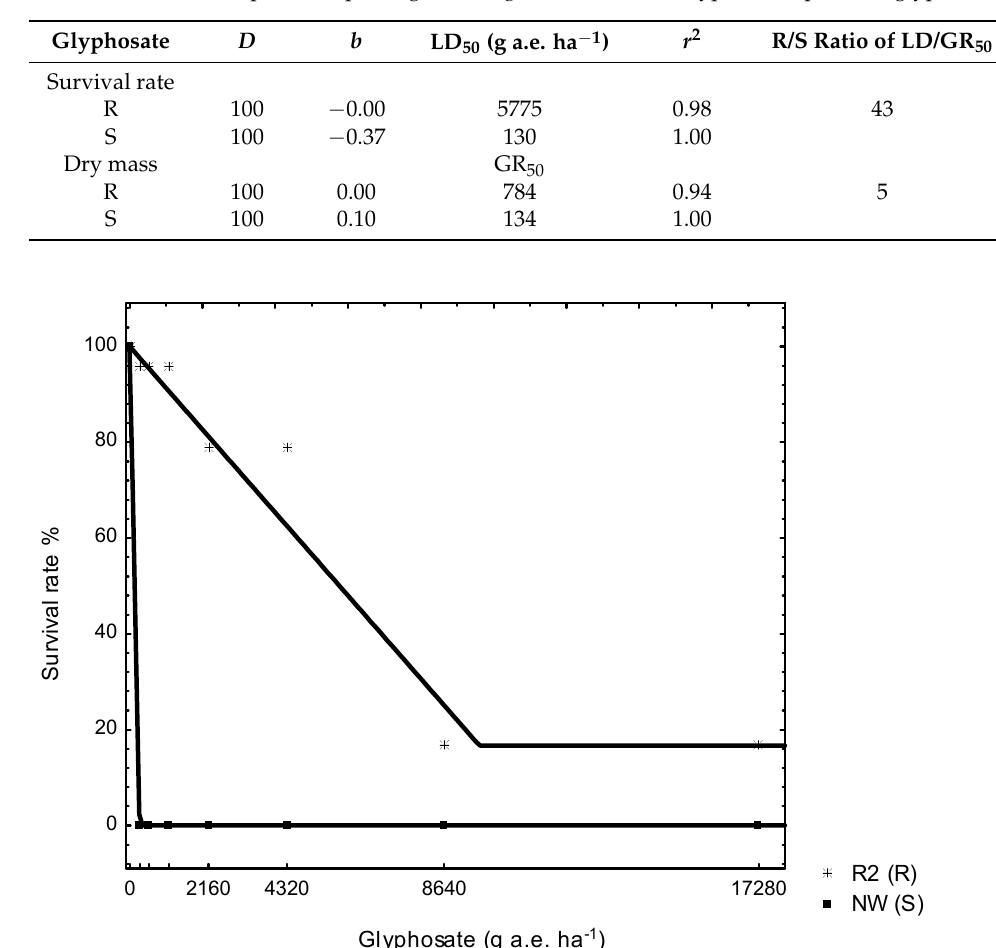
Figure 1. Percentage survival rates of susceptible NW (S) and putative resistant R2 (R) plantago ( Plantago lanceolata L.) biotypes, 42 days after application of different glyphosate dosages